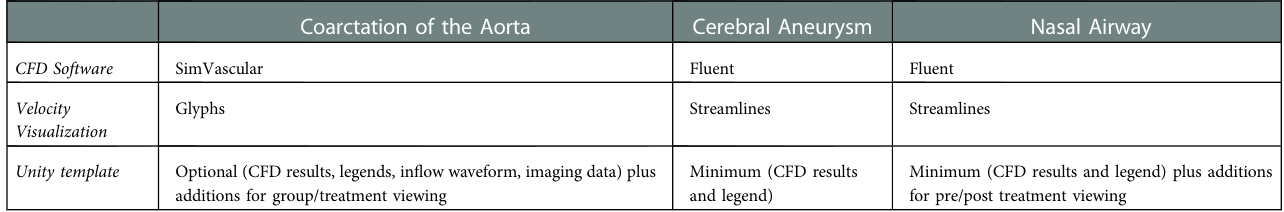
TABLE 3 Portions of work fl ow implemented in the three featured CFD application